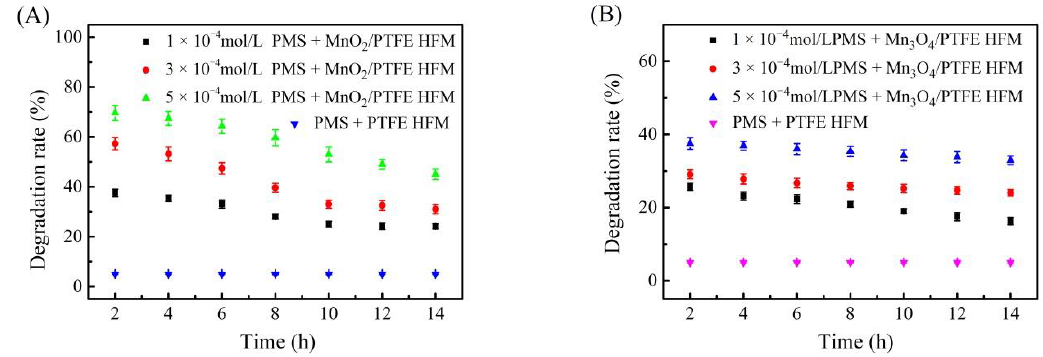
Figure 10. The influence of the concentration of PMS on the degradation of phenol: ( A ) MnO 2 /PTFE HFM; ( B ) Mn 3 O 4 /PTFE HFM.